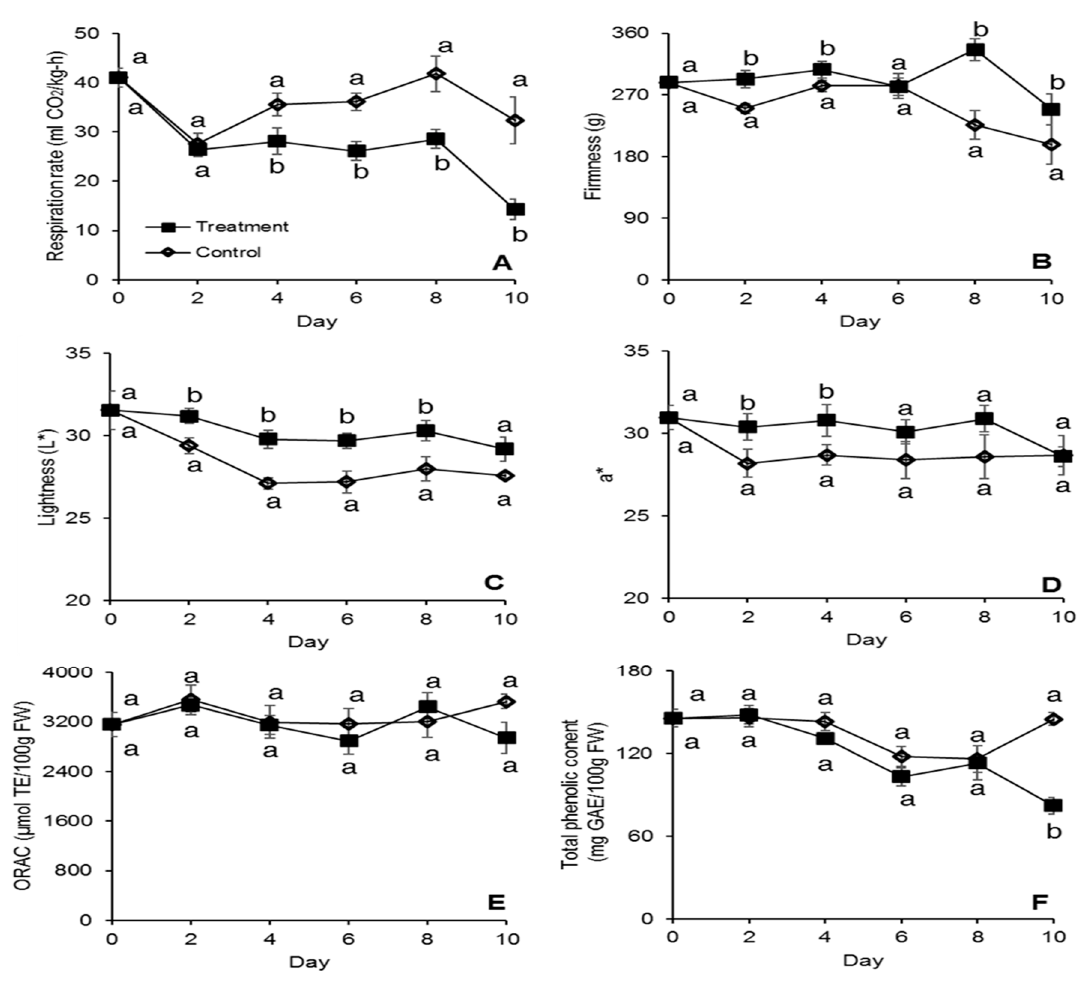
Figure 3. Respiration rate ( A ), fruit firmness ( B ), fruit surface color measured as lightness (L*) ( C ) and a* value ( D ), antioxidant capacity ( E ) and total phenolic content ( F ) of strawberries stored at 3 °C for 10 days in molded fiber baskets containing pullulan packaging films loaded with 1% w/w cinnamaldehyde SLN (treatment) or without (control). Different letters (a, b) for each day denotes a significant difference ( p < 0.05) between the treatment and the control. The error bars represent standard error.